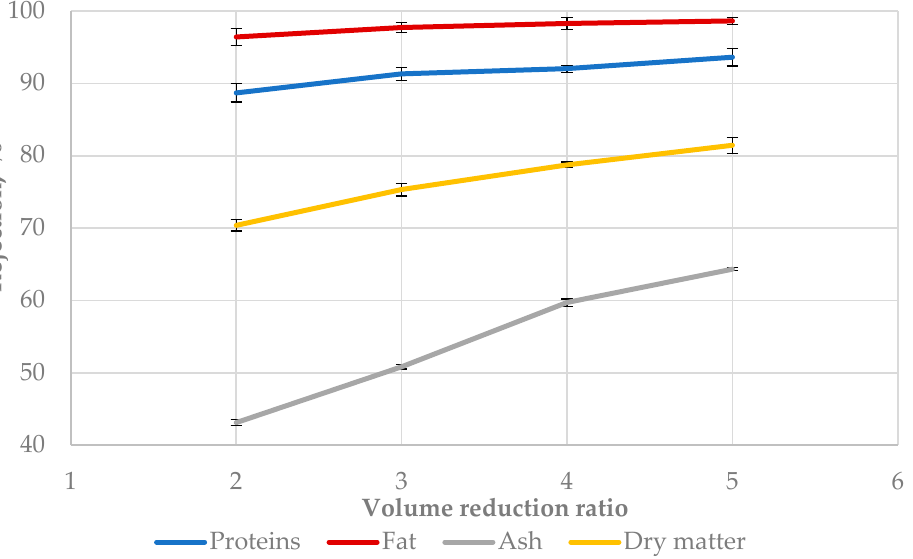
Figure 3. Rejection at different volume reduction ratios during ultrafiltration of sweet buttermilk.